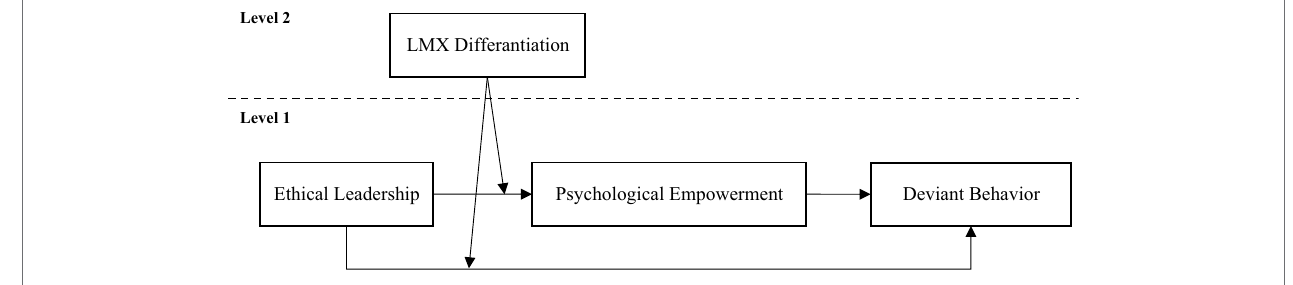
FIGURE 1 | Proposed moderated mediation model linking ethical leadership to deviant